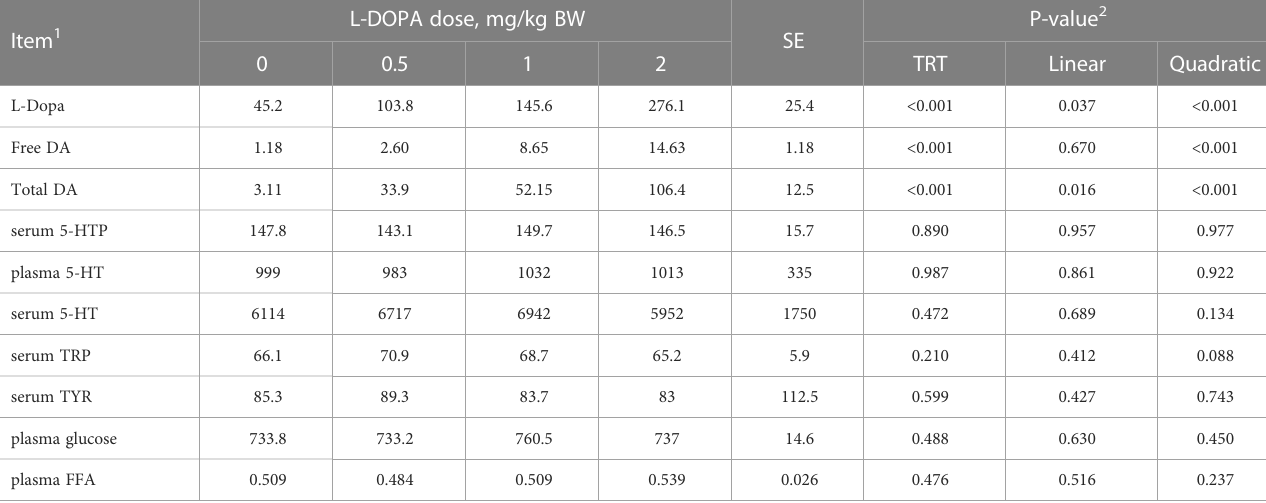
TABLE 2 Area under the curve of circulating metabolites in steers receiving intra-abomasal infusion of levodopa (L-DOPA).